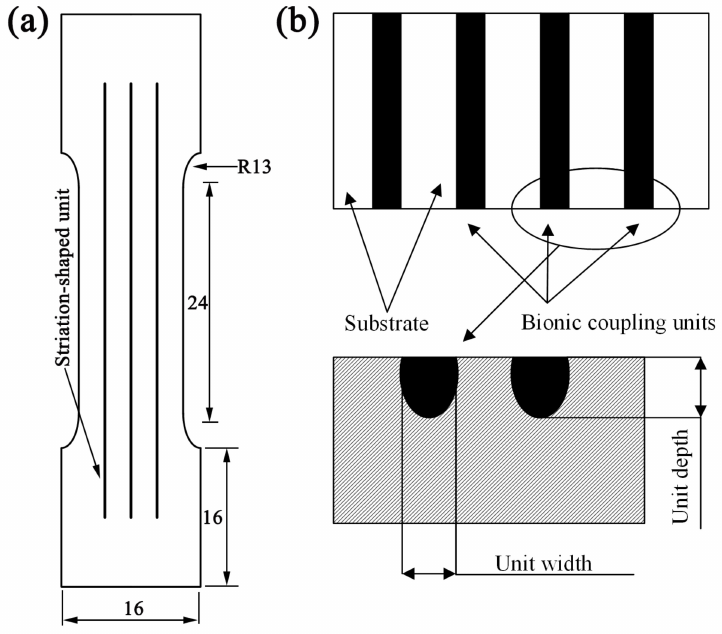
Figure 3. The bionic specimens used for ( a ) tensile and ( b ) wear testing.